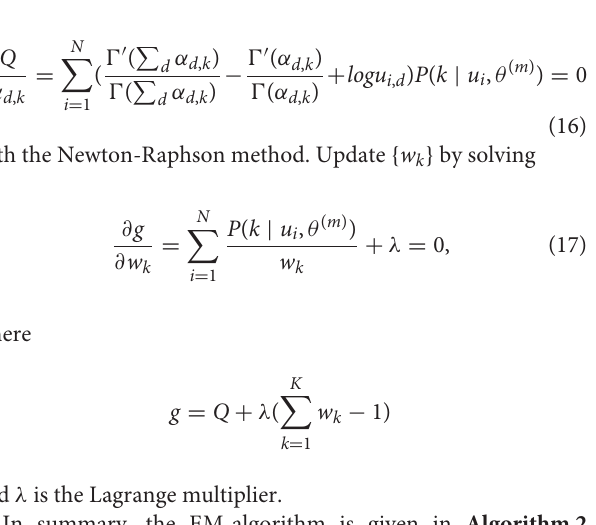
Algorithm 1 Dirichlet Process to Estimate the Number of Components.